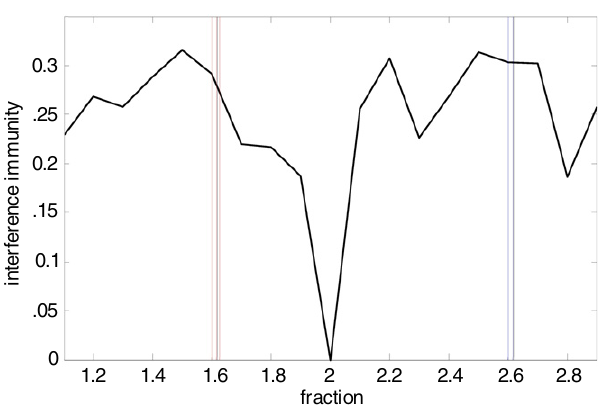
Figure 6. Interference predictions for ratios of frequency